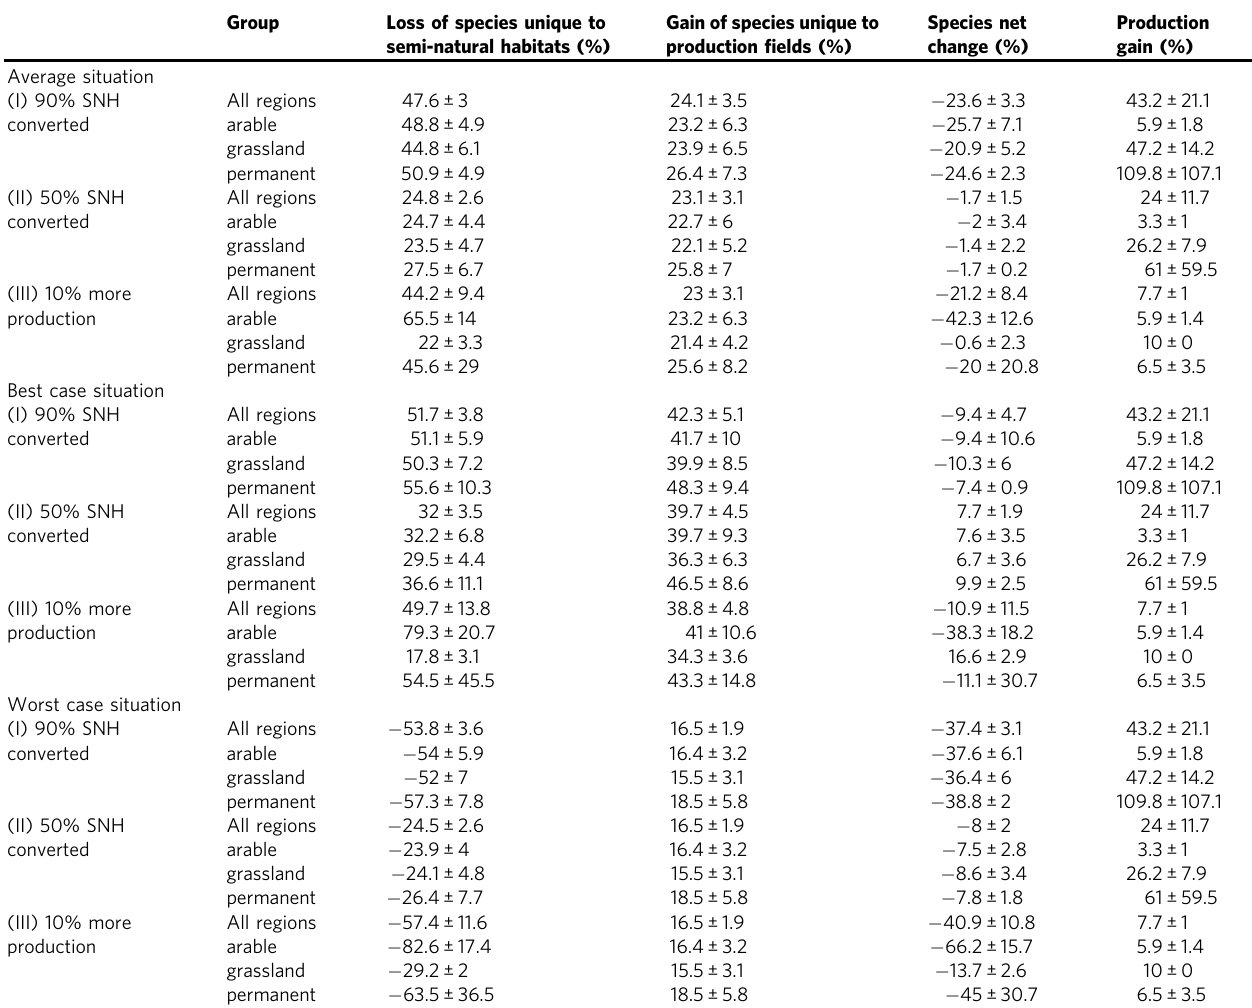
Percent and standard error are shown. Details per region are in Supplementary Table 7. Results are presented for three situations (see Methods): (1) Average situation: richness of unique species estimated from rarefaction and extrapolation curves; (2) Best case situation: species change estimated from the lower bound of the con fi dence interval (CI) of the expected species richness unique to semi-natural habitats, the upper bound of the CI of the expected species richness unique to production fi elds, and the lower bound of the CI of the expected shared species richness; (3) Worst case situation: species richness estimated from the upper bound of the con fi dence interval (CI) of the expected species richness unique to semi-natural habitats, the lower bound of the CI of the expected species richness unique to production fi elds, and shared species assumed to not be able to survive without semi-natural habitats and considered like species unique to semi-natural habitats. Three scenarios are shown: (I) 90% and (II) 50% of the area covered by semi-natural habitats are converted to production fi elds, (III) semi-natural habitats are converted to production fi elds required for a 10% production increase. Means are calculated across all regions and groups of regions, i.e. arable and horticultural (AT, FR, NL and DE), grassland (HU, CH, NO and GB) and permanent crops (IT,